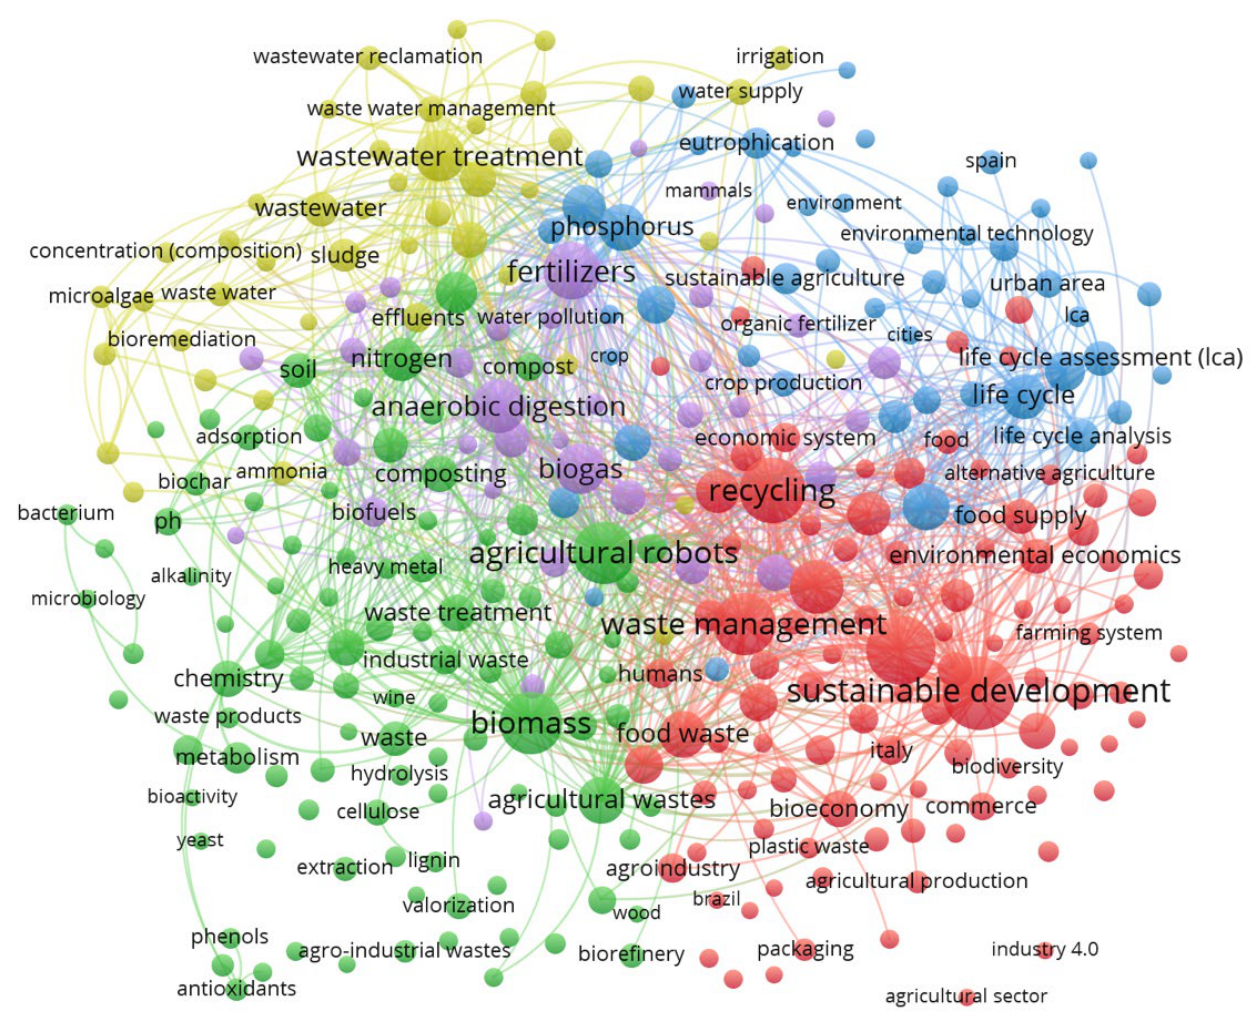
Figure 7. Main keywords’ network based on co-occurrence method (2005–2021).